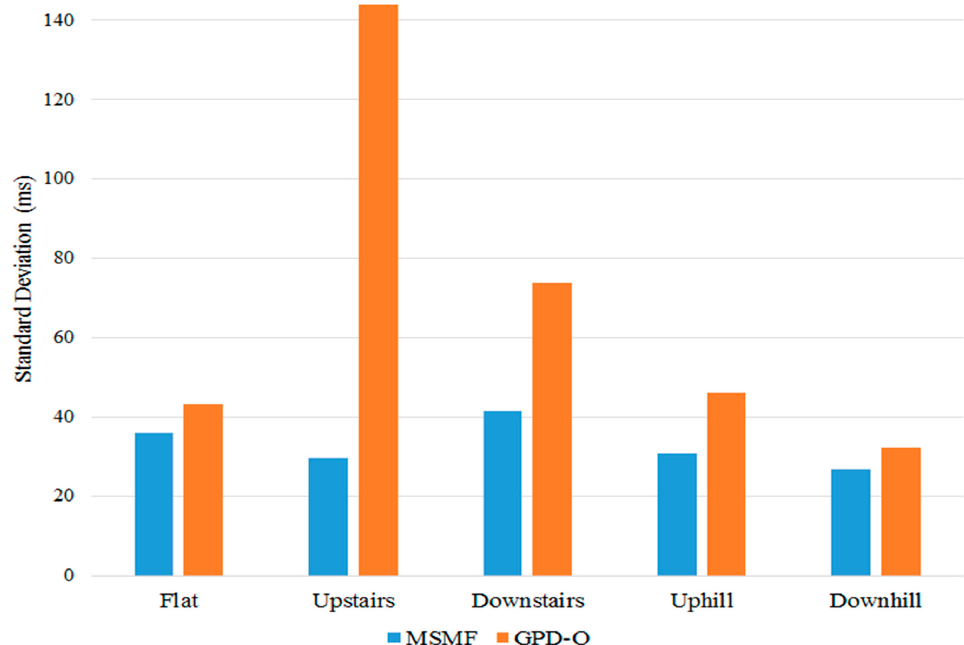
Figure 11. Variation of TC timing error for the MSMF and GPD-O algorithms for different terrains. Timing error is calculated as the difference in time for TC event identified by the algorithms and the push-switch.